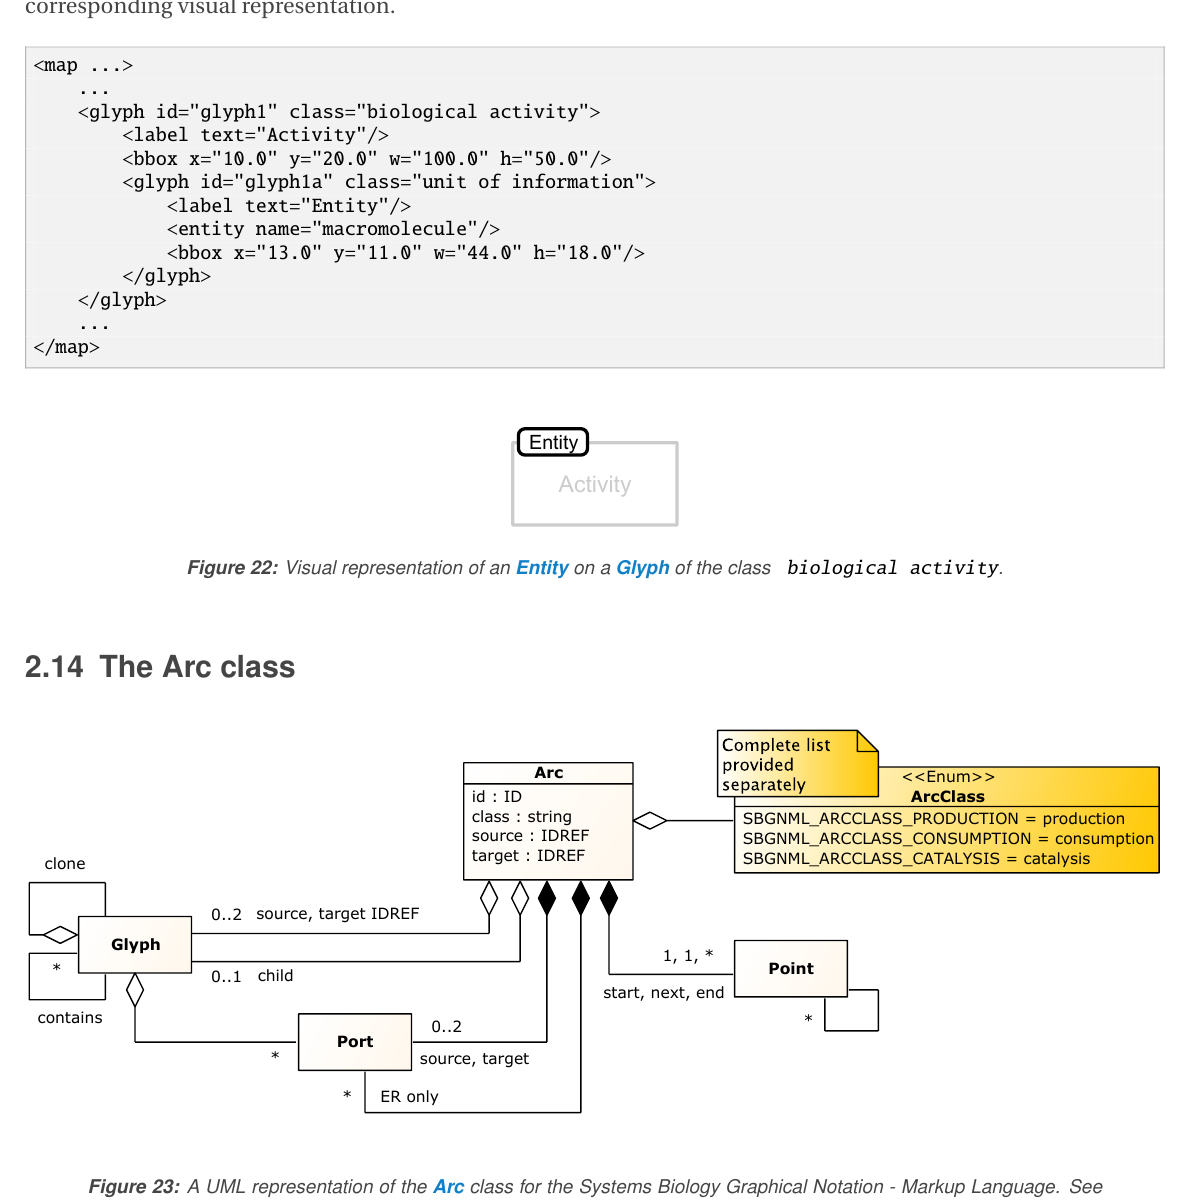
The arc element describes an SBGN arc between two SBGN nodes. It contains: 23 For PD maps: an optional stoichiometry ■